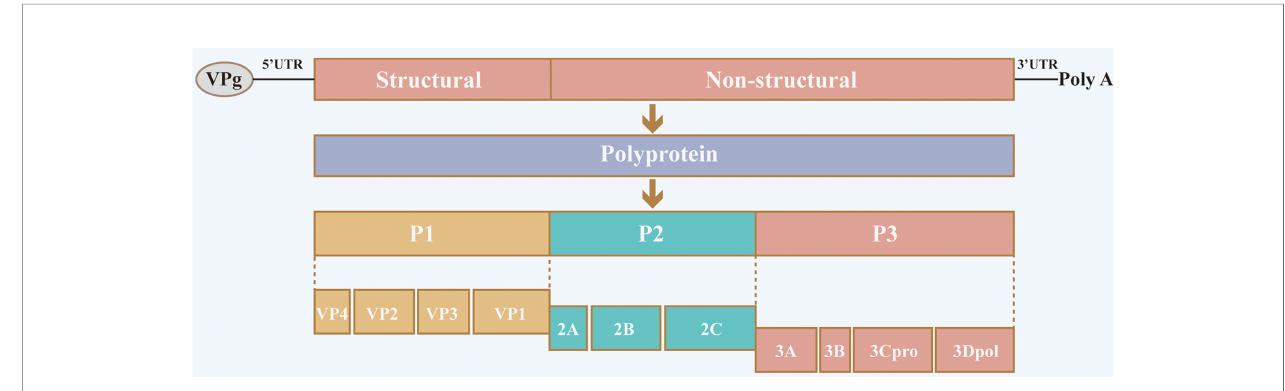
FIGURE 1 | Schematic diagram of SVA structure and genome organization. The SVA genome comprises a large single open reading frame (ORF) fl anked by highly structured 5 ′ and 3 ′ untranslated regions (UTR). The single ORF is translated into a single polyprotein, which is processed by viral proteases into multiple protein products P1 (VP4, VP2, VP3 and VP1), P2 (2A, 2B and 2C) and P3 (3A, 3B, 3Cpro and